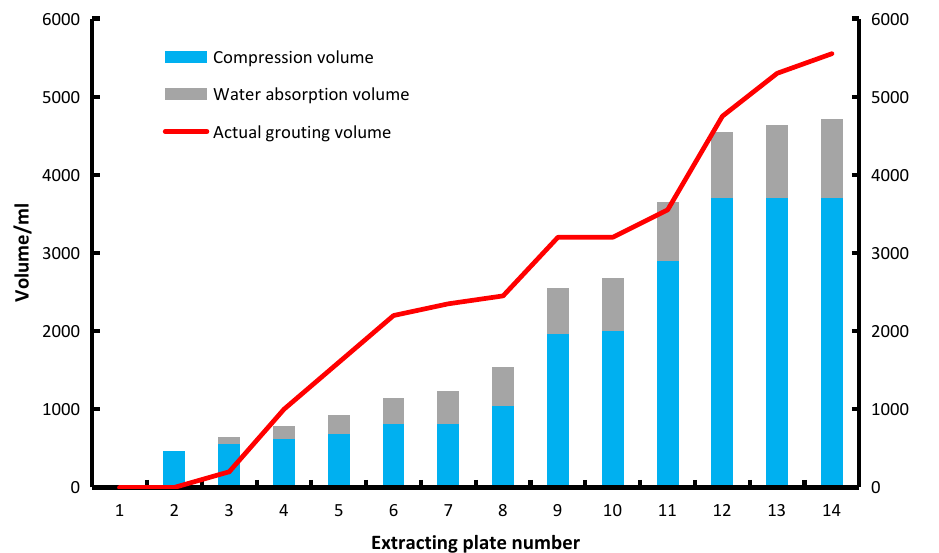
Figure 11. Comparison of injected slurry volume and solid